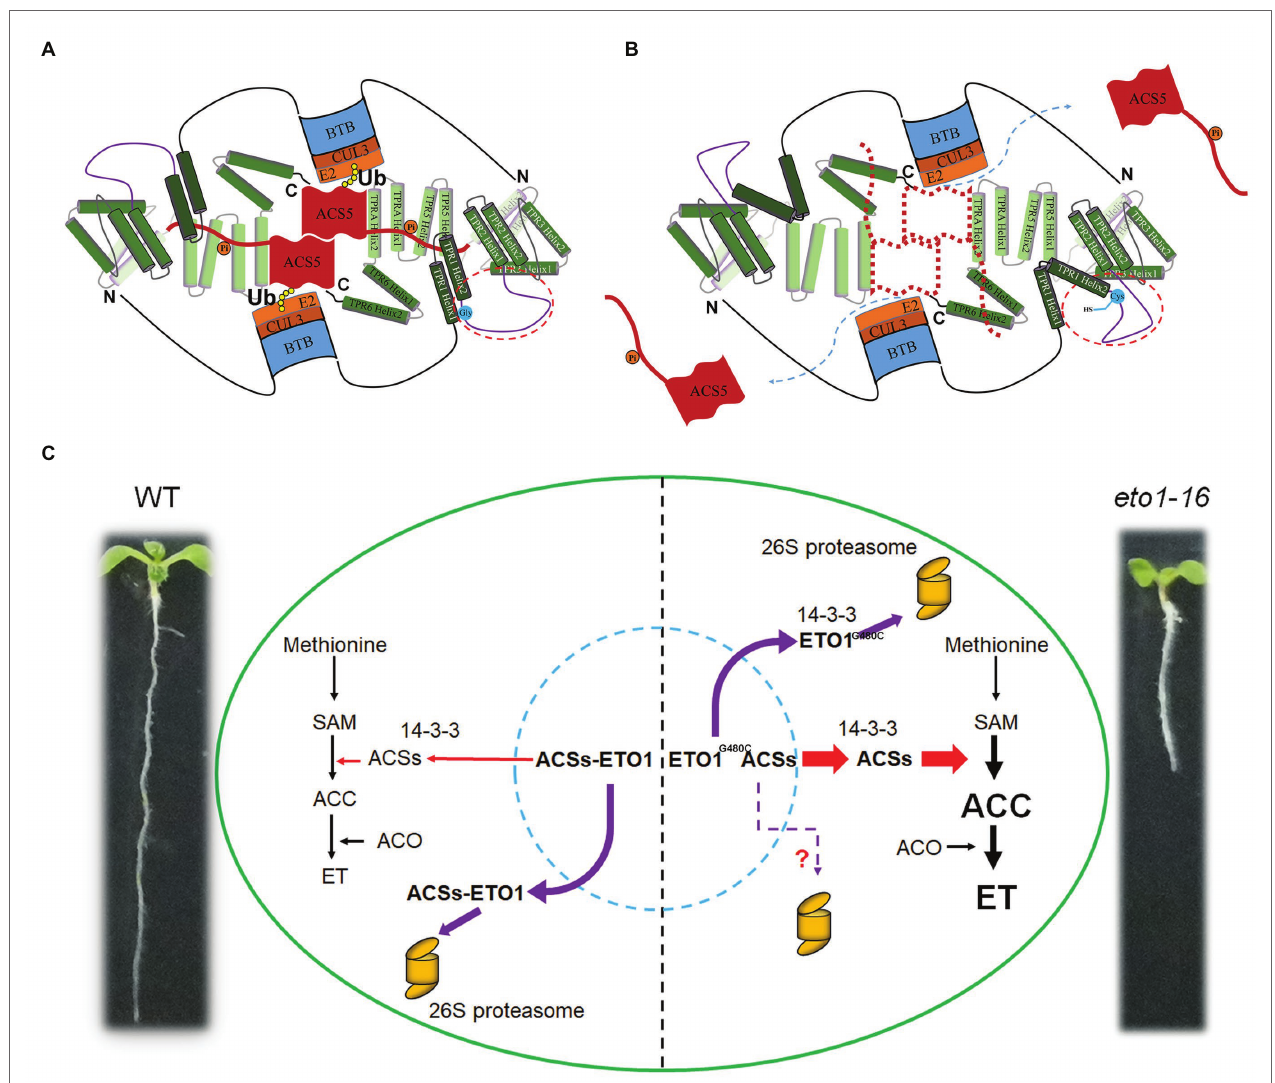
FIGURE 7 | Schematic binding model of ETO1 with ACS5 and pool of ETO1 and ACS5 in WT and eto1-16 . (A) Tetratricopeptide repeat (TPR) motifs of ETO1 bind to the extended C-terminus of ACS5 in WT. The dimerization of ACS5 and phosphorylation (orange circles labeled with “Pi”) enhance the binding of ACS5 to ETO1. Ubiquitination (Ub) is indicated as yellow filled circles. Except for the BTB domain and TPR motifs, other regions are represented as lines. The linker sequence between TPR1 and TPR2 is encircled by red dotted lines, and the mutation site is labeled by blue filled circles. “N” and “C” represent the N terminus and C terminus of ETO1, respectively. (B) The potential conformation change in linker sequence caused by eto1-16 mutation disrupted the protein interaction between ETO1 and ACS5 and released ACS5 from the complex. (C) Regulation of ACS5 activity by ETO1 in WT and eto1-16 . ETO1 interacts with ACS5, inhibits its enzyme activity, and targets it for proteasome-dependent degradation via interaction with the scaffold subunit CUL3A. In eto1-16 , disruption of the interaction between ETO1 and ACS5 releases them from the complex. The ETO1 is degraded by the 26S proteasome, whereas the functional ACS5 catalyzes the S-adenosylmethionine (SAM) to ACC